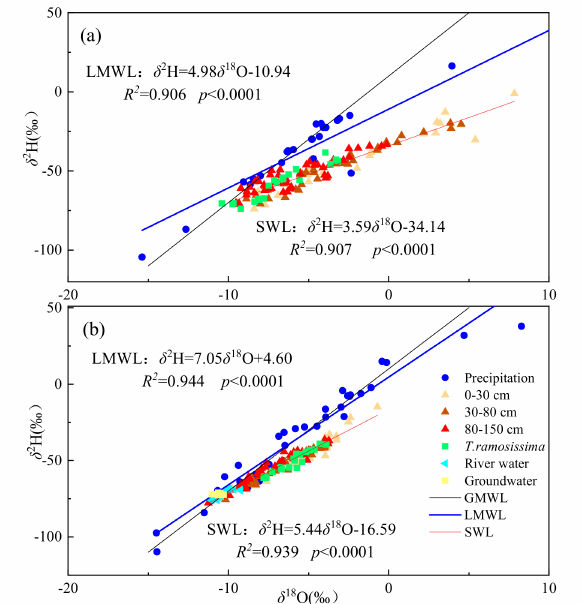
Figure 4. The distribution characteristics of δ 18 O and δ 2 H of precipitation, xylem water, Yellow River water, groundwater, and di ff erent depth of soil water at the hillside ( a ) and floodplain ( b ) habitats during the sampling periods. SWL is the soil water line. LMWL is the local meteoric water line, GMWL represents the global meteoric water line ( δ 2 H = 8 δ 18 O + 10).